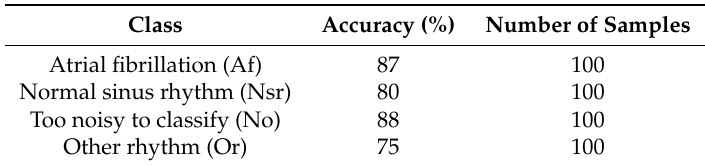
Figure 9. Confusion matrix of time domain. Table 1. Accuracy for each class in time domain. Samples used are the same ECG signals converted into